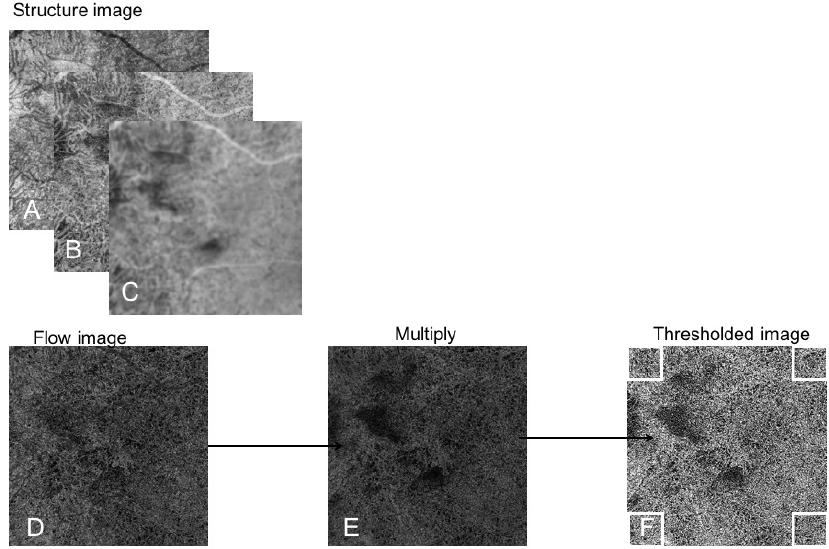
Figure 1. Image processing methodology used for quantification of the choriocapillaris flow. En face choriocapillaris structure image ( A ) was transformed using the Fiji “Invert” function ( B ). Gaussian blur filter was then used for smoothing ( C ). The en face choriocapillaris flow image ( D ) was multiplied with the resulting en face choriocapillaris structure image ( C ) with the “Image Calculator” function. A compensated en face choriocapillaris image was created ( E ). The compensated en face